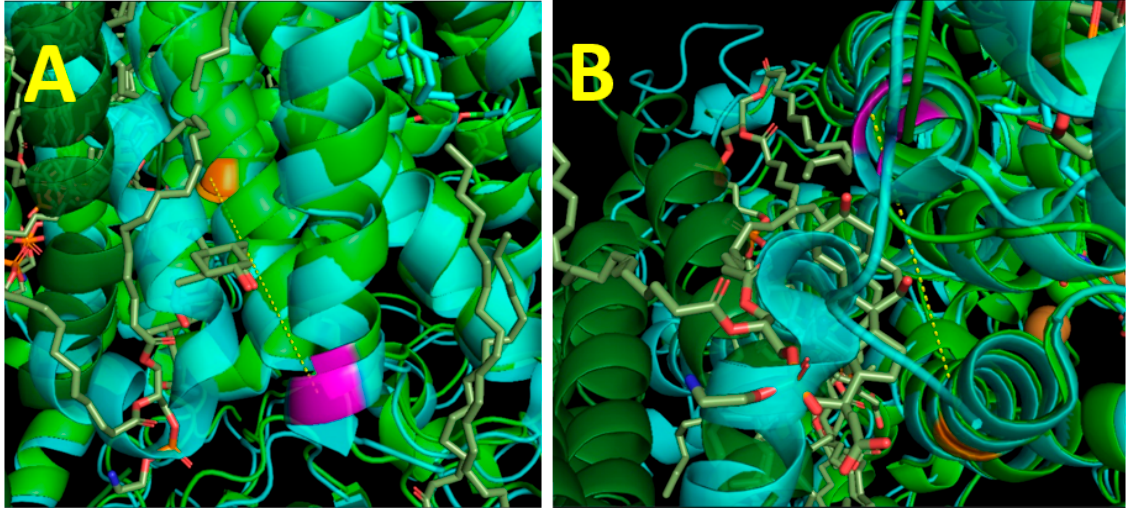
Figure 3. Binding sites for amphipathic ligands in mitochondrial CcO. ( A ) Side view. ( B ) View from the inner membrane surface. The structures of the dimer (formed by light green and a deep green monomers; PDB entry 3ASO) and the monomer (cyan; PDB entry 5Z62) are superimposed. In the center of the image in ( B ), one can see the NDUFA4 subunit, which is present only in the monomeric structure and is involved in the regulation of the monomer–dimer transition [56]. Lipids are grey, with red O and blue N atoms. BABS is marked by E62 II , colored in purple. SBSM is marked by M278 I , colored in orange. The distance between E62 II and M278 I (yellow dashed line) is 20 Å. The cholate bound in BABS is grey with red oxygens. The distance from cholate’ hydroxyl 7 to carboxyl of E62 II is 2.8 Å, and the nearest distance from the cholate to M278 I is about 8 Å.